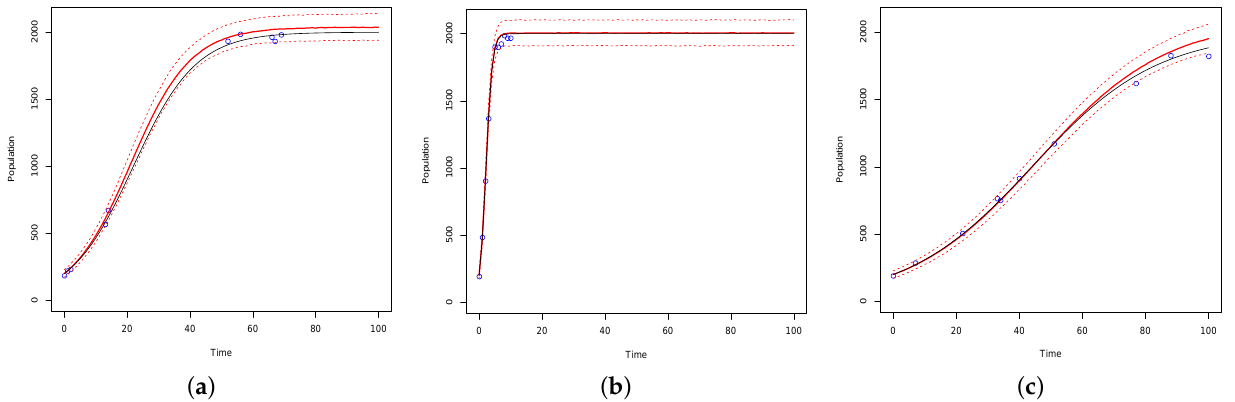
Figure 4. 10,000 MCMC samples are used to simulate A Φ —optimal designs for ( a ) normal, ( b ) fast and ( c ) slow growth models. All models are simulated across 100 time points with a carrying capacity of 2000. The ground truth models are plotted in black. The optimal design points are plotted in blue and fit by a solid red curve, where the 2.5% and 97.5% quantiles of the predicted values are plotted as red dotted